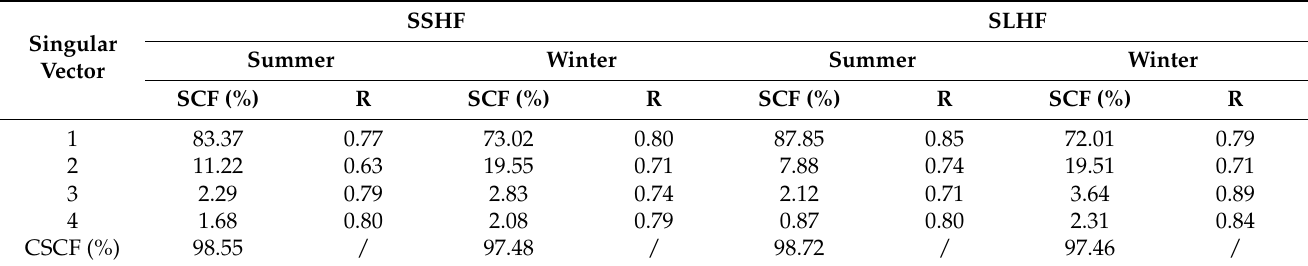
Table 4. SVD Analysis of surface flux and eastward water vapor flux in Southeast